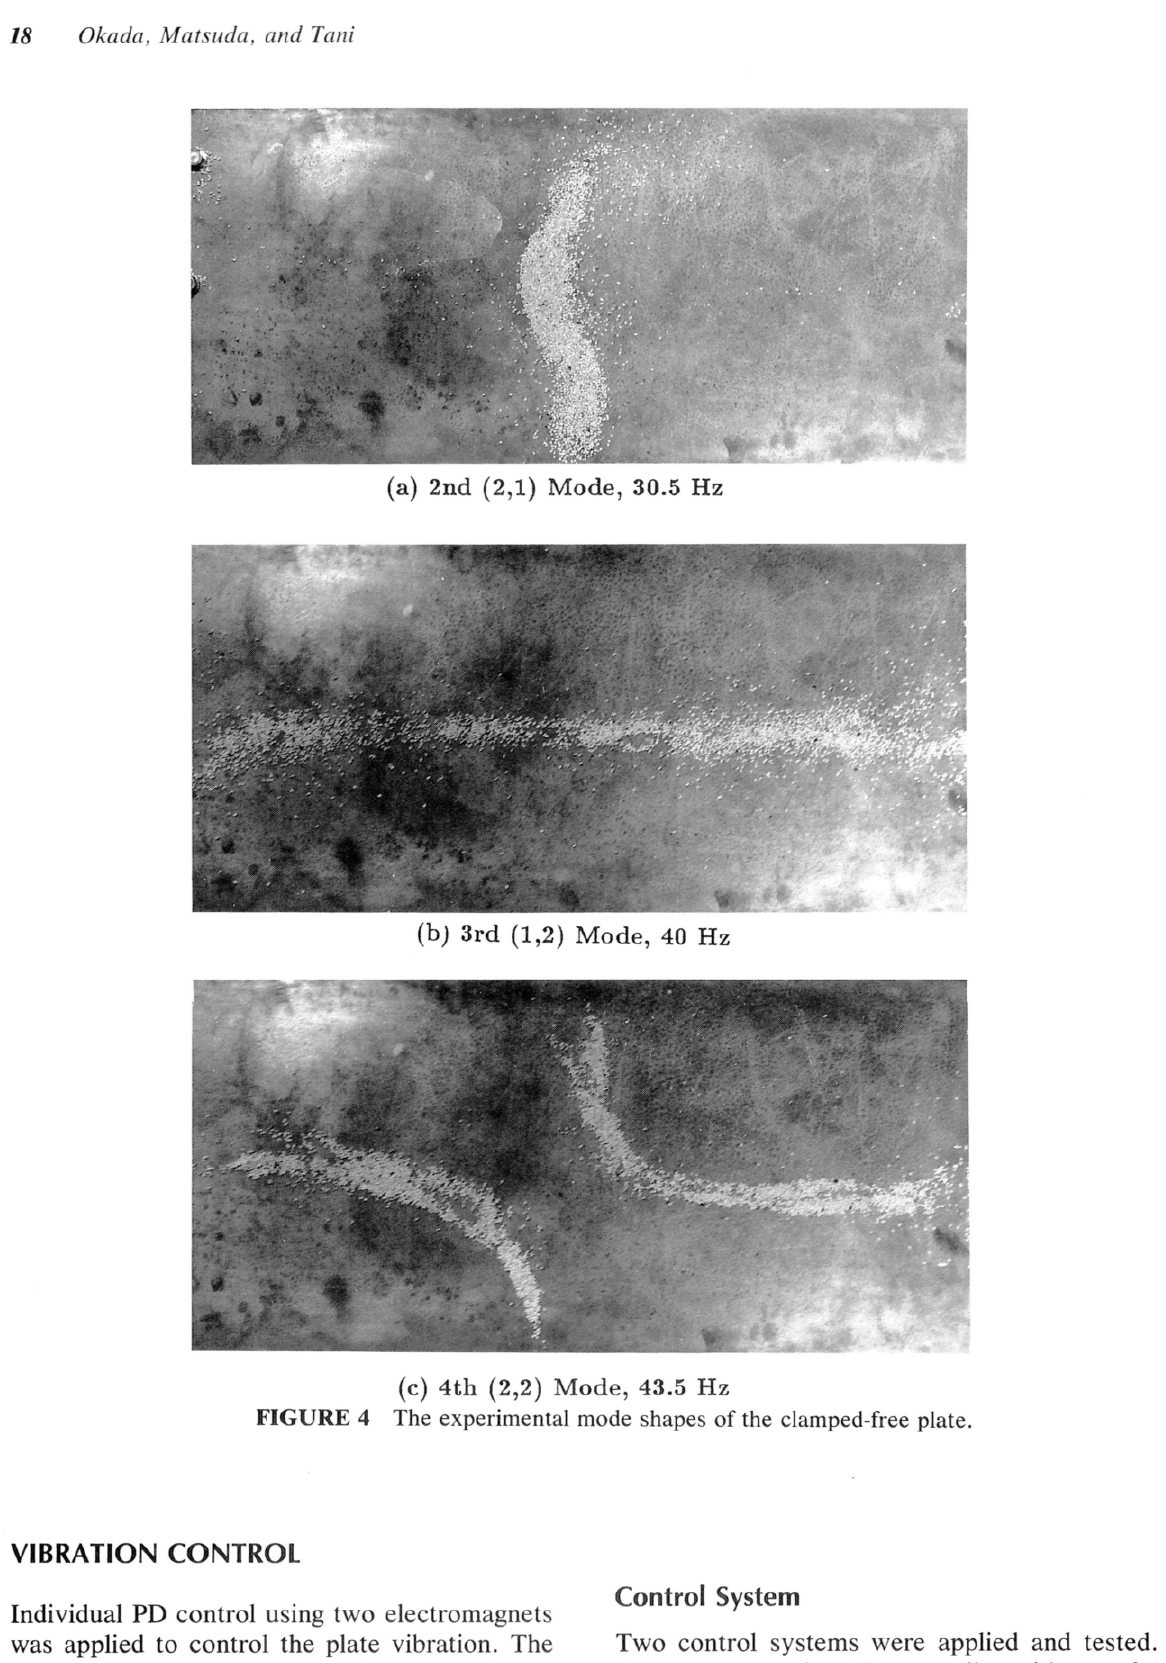
VIBRATION CONTROL Individual PD control using two electromagnets was app lied to control the plate vibration. The locations are Xl = 18 cm, Yl = 5 cm, X2 = 63 cm, = 30 Y2